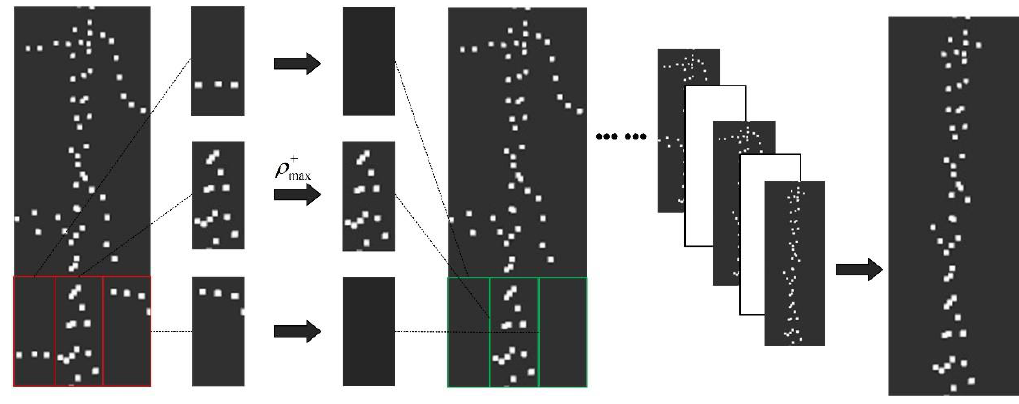
Figure 6. Schematic of the second search window.